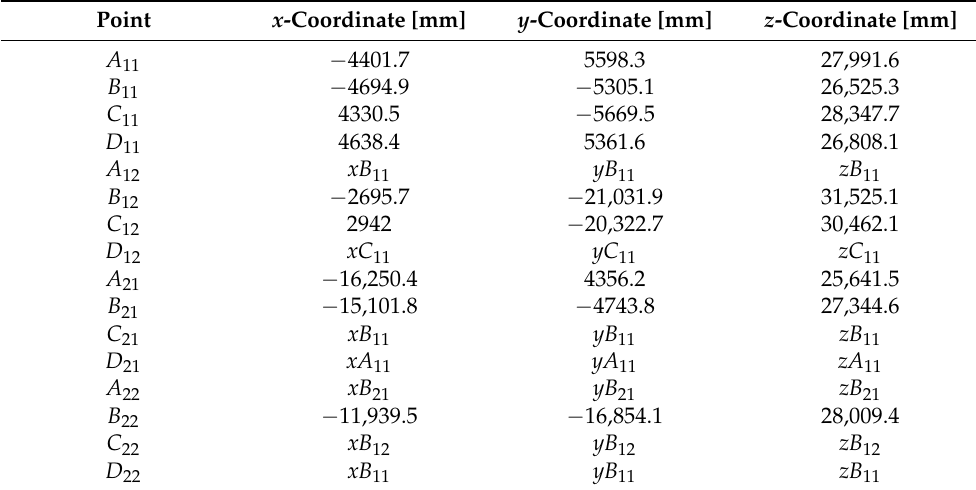
Table A10. The coordinates of the vertices A ij , B ij , C ij , D ij (for i , j = 1, 2) of the eaves edge net B v 1 (and the third structure Σ 3